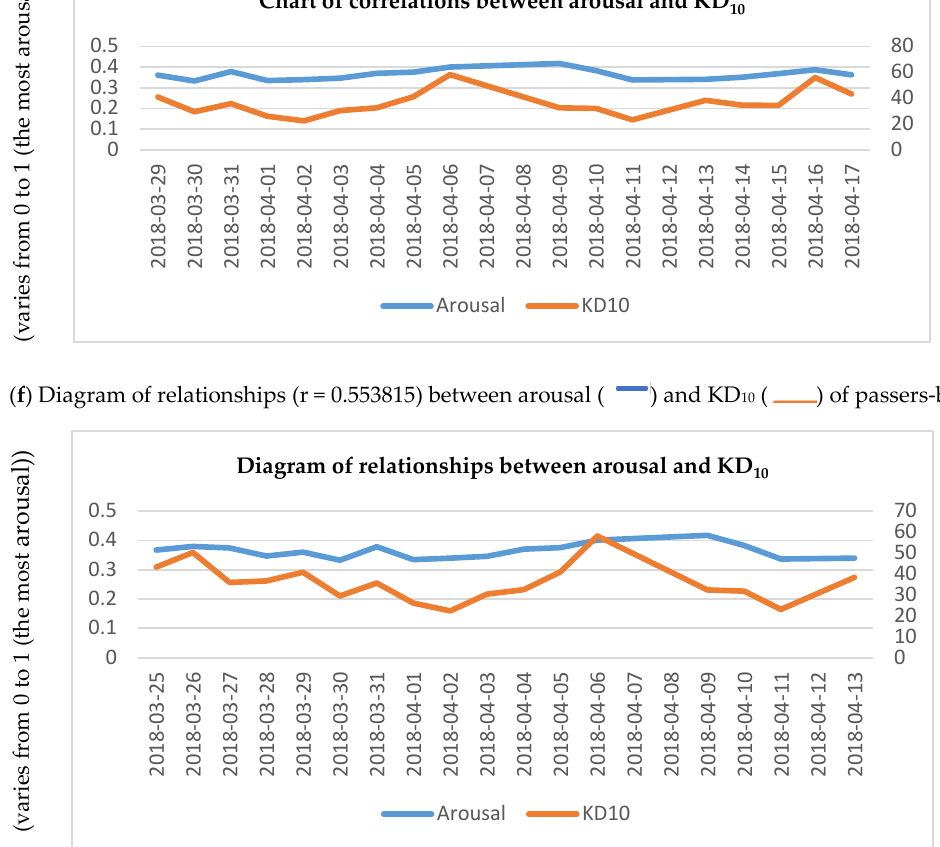
Arousal KD10 Figure 3. Cont